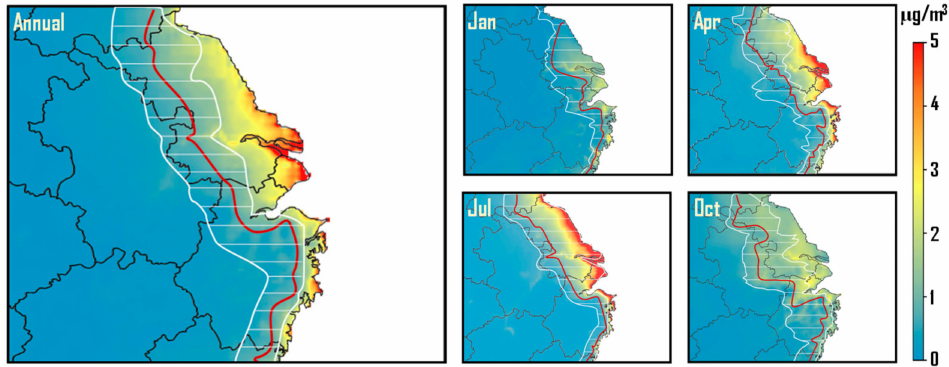
Figure 7. The inter-annual variation ranges of distribution of annual and seasonal ship-contributed PM 2.5 in